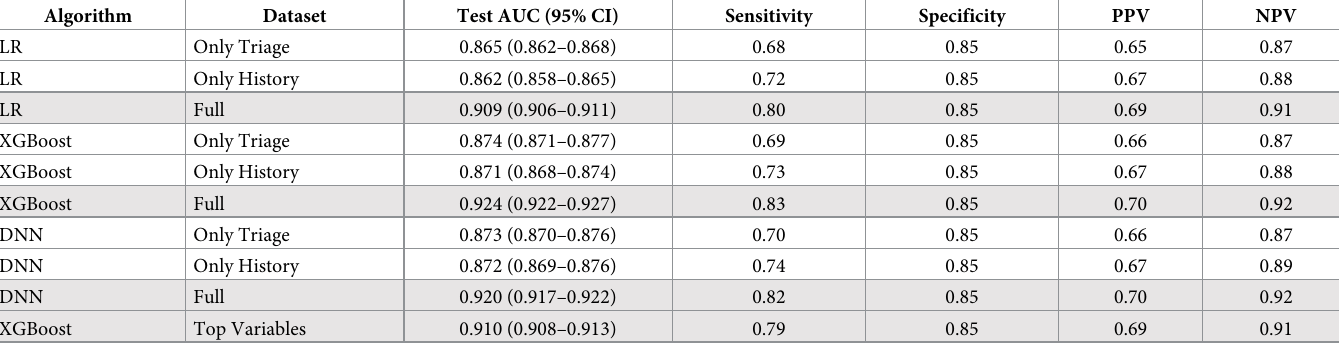
Table 3. Summary of statistical measures for each model.